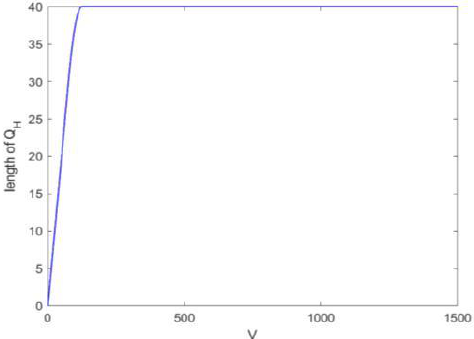
Figure 3. The weight-dependent trend of average delay.